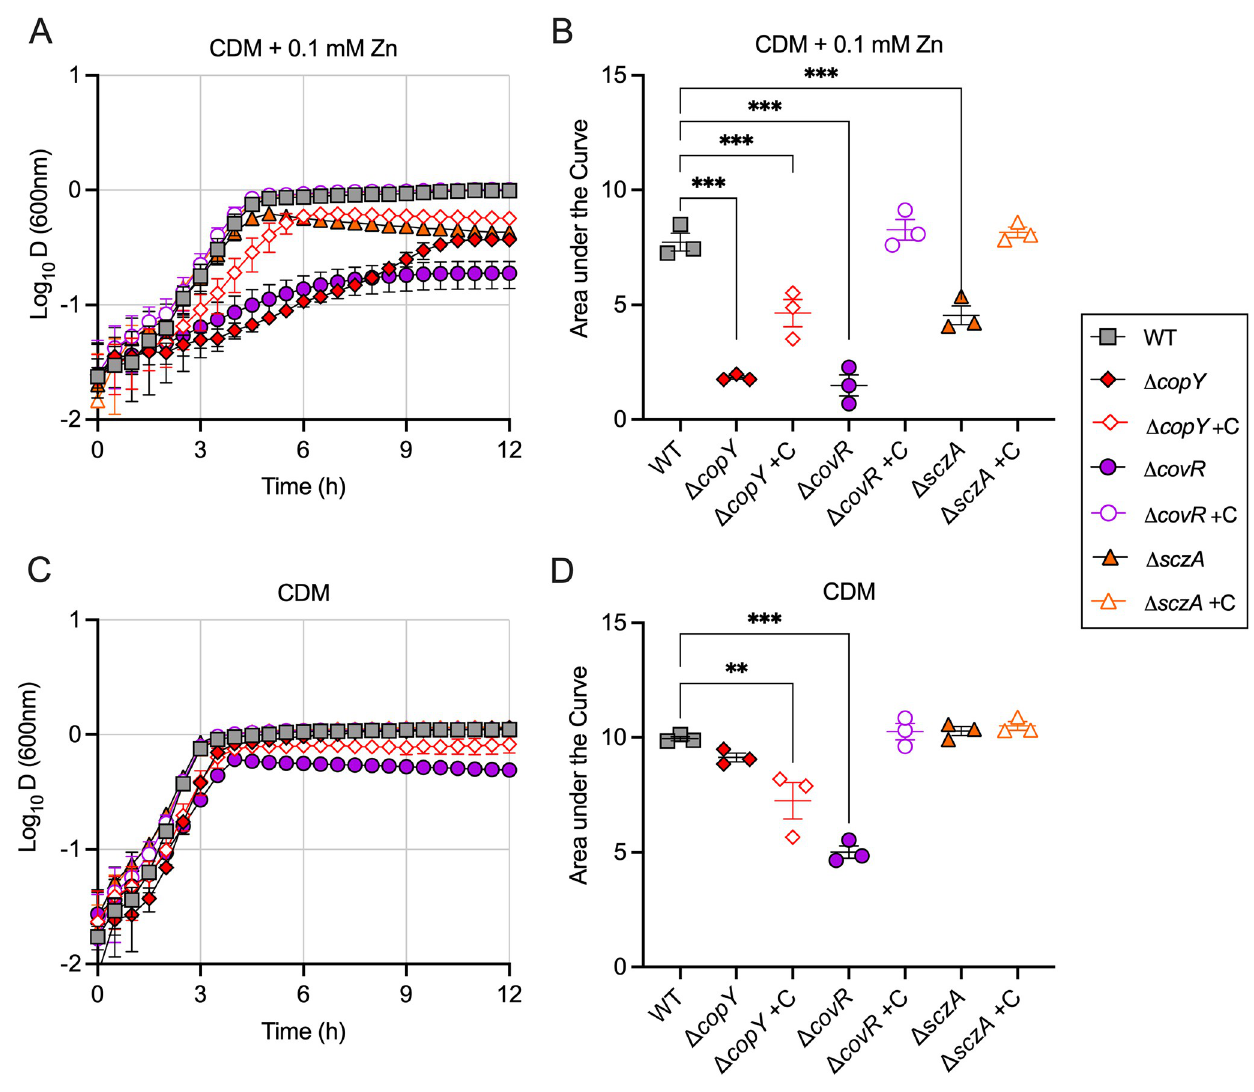
Fig 1. Growth of GBS in CDM using conditions of Zn stress. WT, Δ copY , Δ covR and Δ sczA mutants and corresponding complemented strains (indicated by +C) were grown in CDM medium supplemented with 0.1 mM Zn (A) and compared (B) using Area Under the Curve analysis followed by ordinary one-way ANOVA and Holm Sidak multiple comparisons ( �� P < 0.01, ��� P < 0.005). Growth curves of the bacteria in control conditions (CDM medium alone) are shown for comparison (C) and compared (D) using Area Under the Curve analysis in followed by ordinary one-way ANOVA and Holm Sidak multiple comparisons ( �� P < 0.01, ��� P < 0.005). Measures of Attenuance ( D at 600nm) or Area Under the Curve lines shown are mean ± S.E.M ( n = 3 biological repeats).